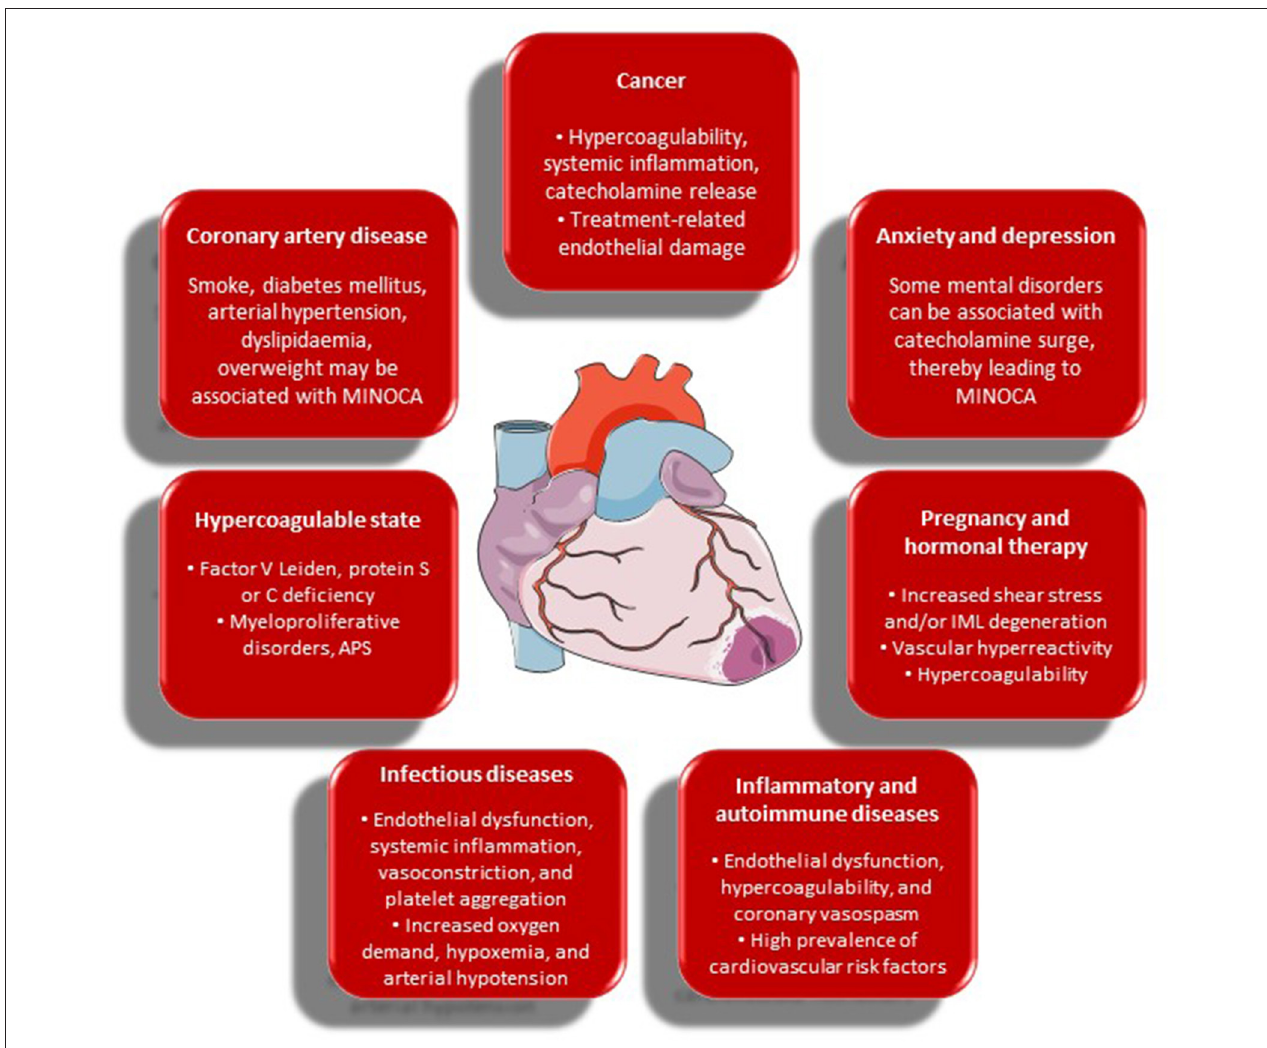
FIGURE 2 | Risk factors and comorbidities of MINOCA and their possible contributory role in its occurrence. APS, antiphospholipid syndrome; IML, intima-media layer; MINOCA, myocardial infarction with non-obstructive coronary arteries.